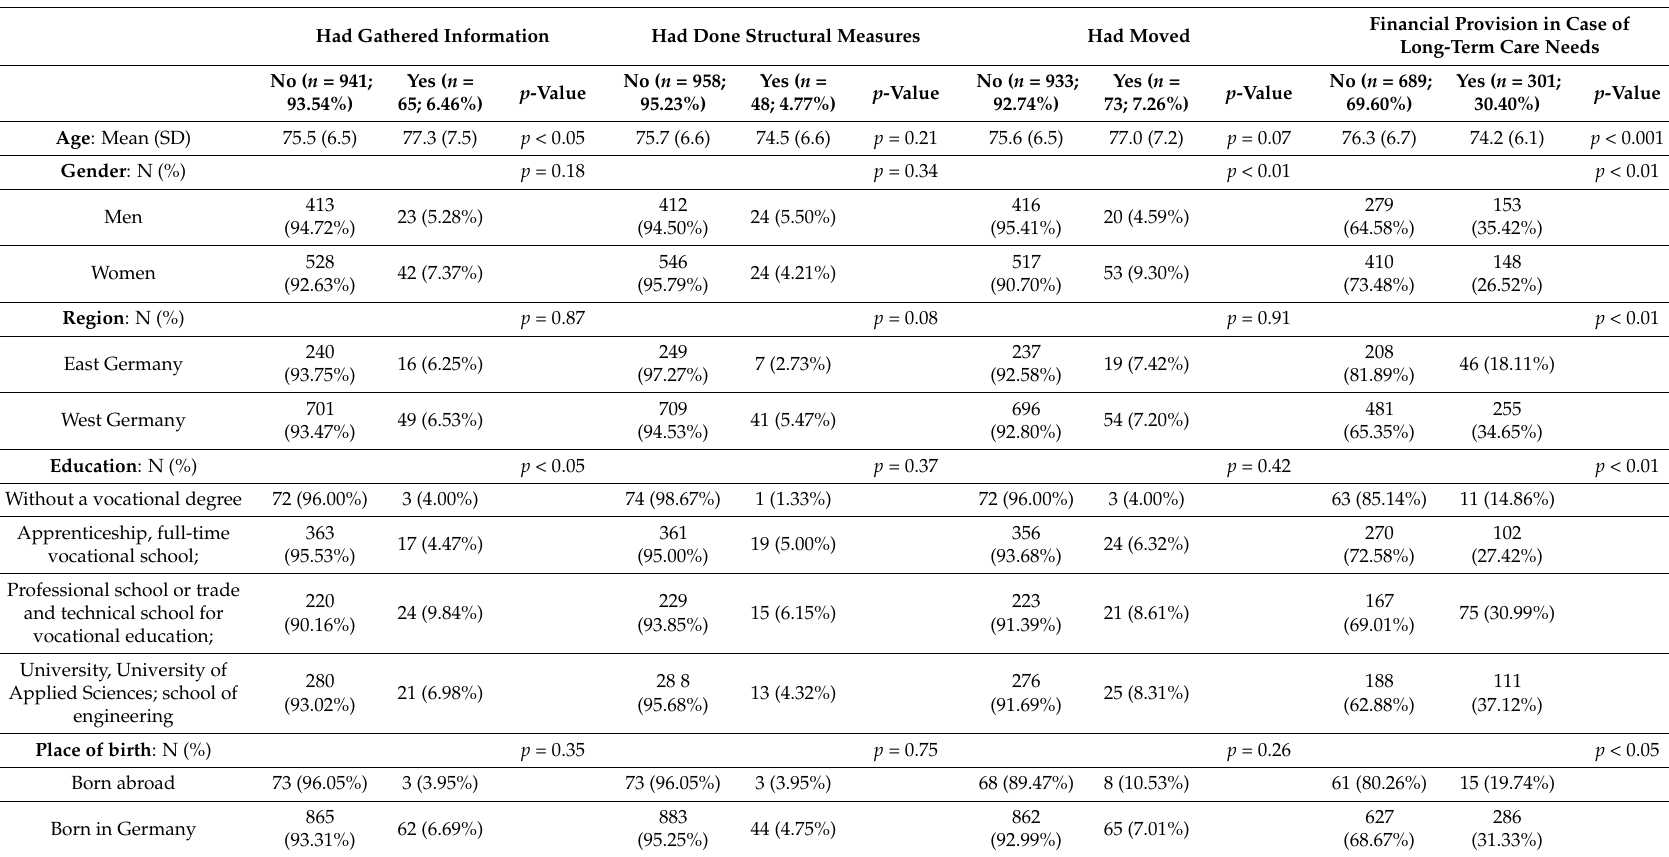
Table 1. Bivariate associations between specific actions and financial provision in case of long-term care needs and independent variables. Had Gathered